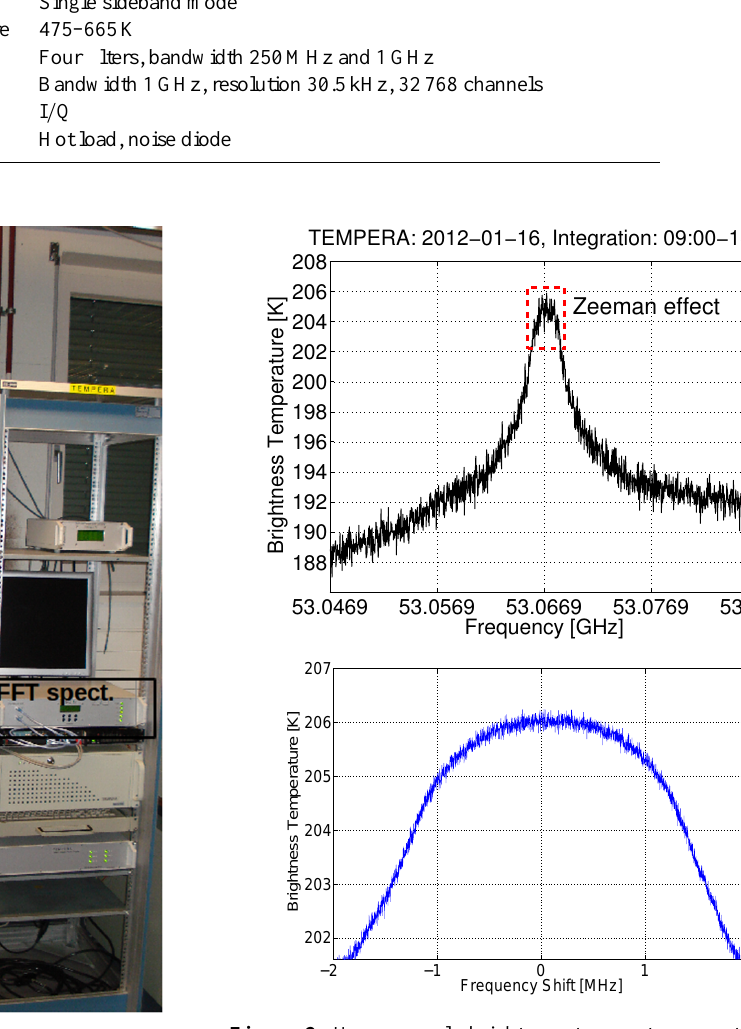
Figure 2. Upper panel: brightness temperature spectrum mea- Figure 1. TEMPERA at the laboratory at ExWi, Bern (Switzer- sured with the FFT spectrometer in the oxygen emission line of Fig. 2. a) Brightness temperature spectrum measured with the FFT spectrometer in the oxygen emission line land). 53.07GHz. The red box indicates the broadened line shape due to of 53.07 GHz. The red box indicates the broadened line shape due to the Zeeman effect. b) Monthly mean the Zeeman effect. Lower panel: monthly mean brightness temper- brightness temperature spectrum measured with the SDR spectrometer. ature spectrum measured with the SDR 16 January of 2012 for the oxygen emission line centered at 53.07 GHz. The red box indicates the influence of the Zee- man effect by the broadened line shape in the center with a kind of a plateau (round line shape around the line center: ± 1 MHz).